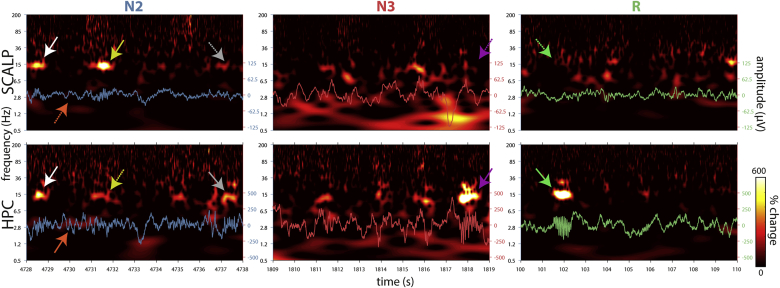
Examples of scalp and hippocampal sleep activity. Shown are 10 s segments of artifact-free data from a single patient (p4). Note the different amplitudes of scalp and hippocampal traces. Spectrograms show percent amplitude change relative to mean across all artifact-free N2, N3 and REM sleep. Arrows illustrate phenomena described in the main text (solid: stronger effect; dashed: weaker effect). Hippocampal channel located in posterior hippocampus (TL08 in Fig. 4AC).